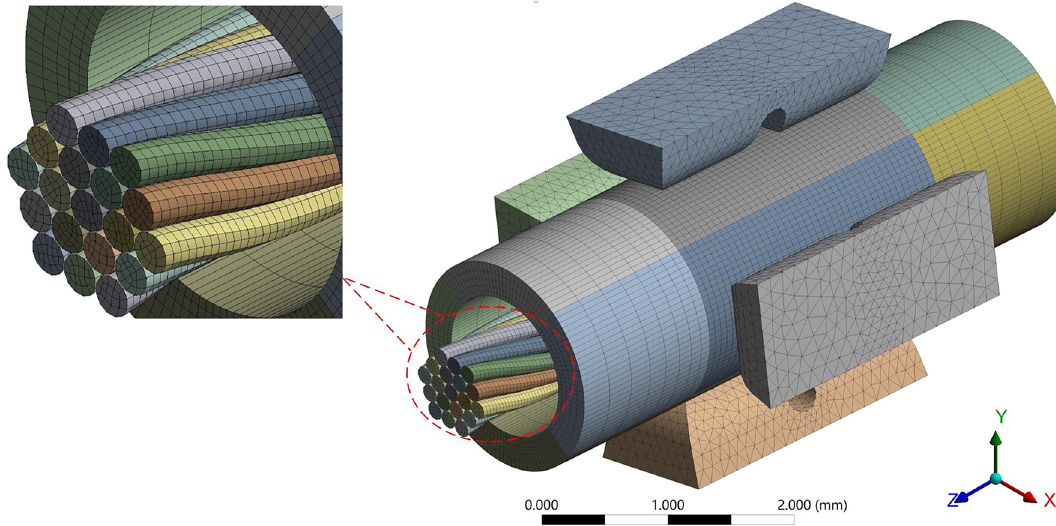
Figure 4. Meshing of the crimping model.